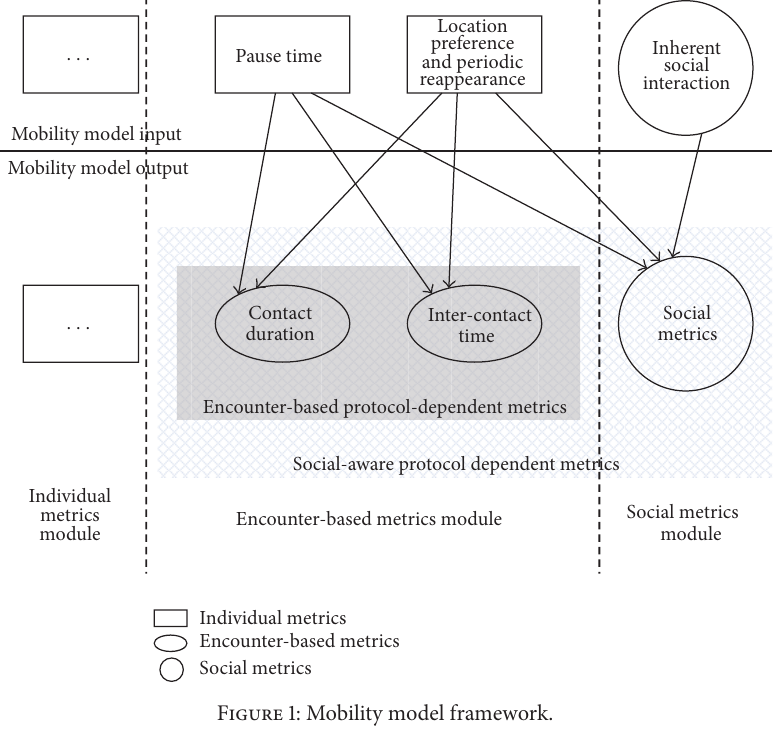
Figure 1: Mobility model